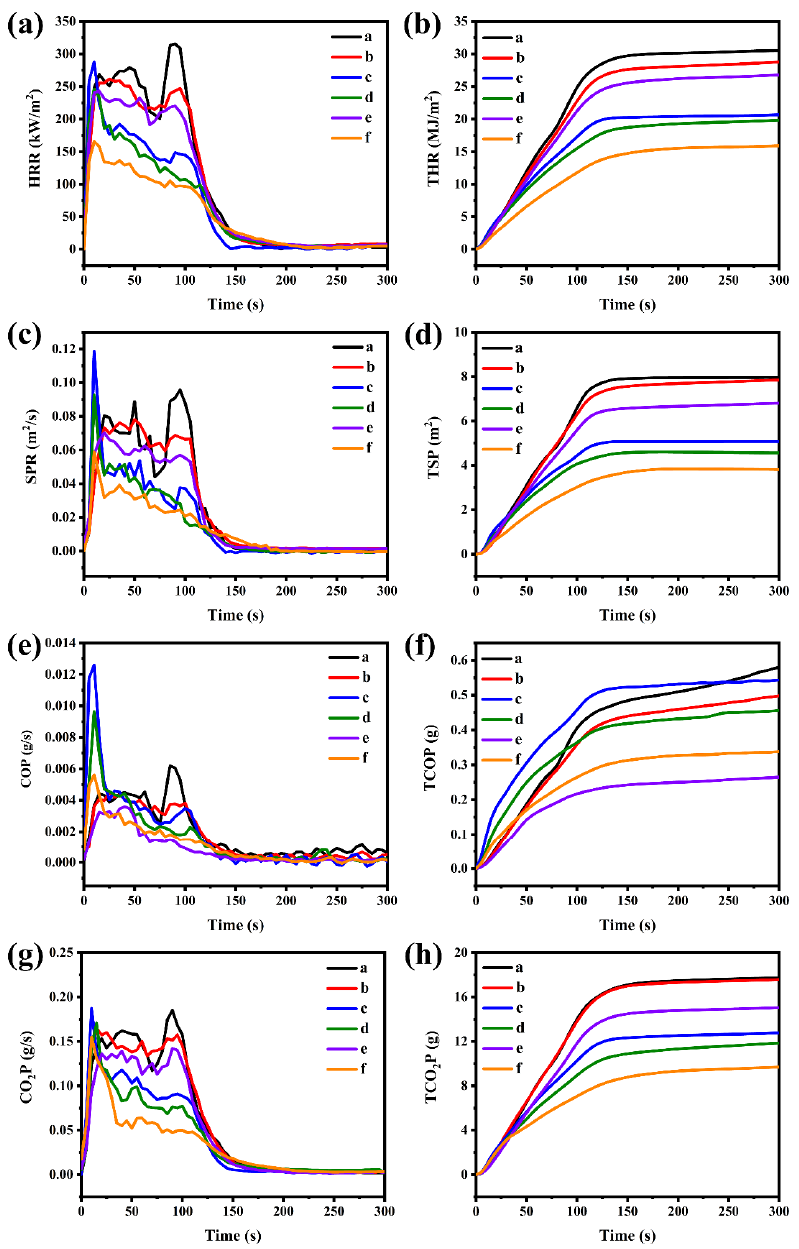
Figure 11. HRR curves ( a ), THR curves ( b ), SPR curves ( c ), TSP curves ( d ), COP curves ( e ), TCOP curves ( f ), CO2P curves ( g ), and TCO2P ( h ) of neat RPUF, RPUF-MOF/MWCNTs 2, RPUF-T, RPUF-